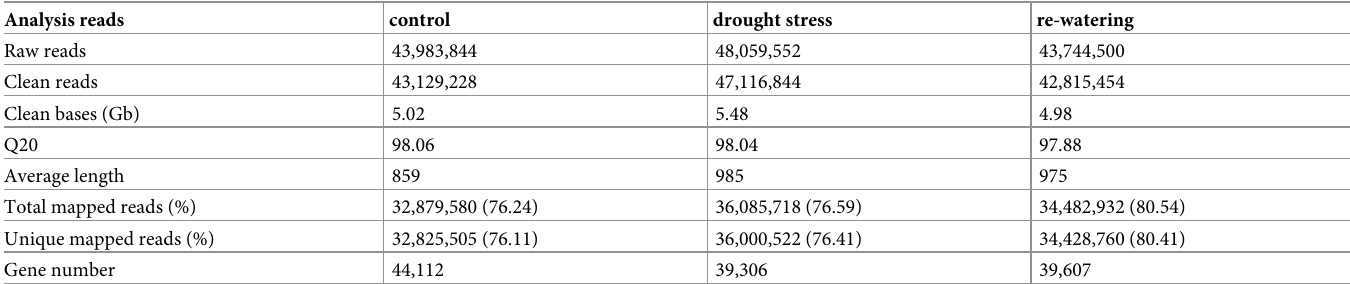
Table 1. Original data